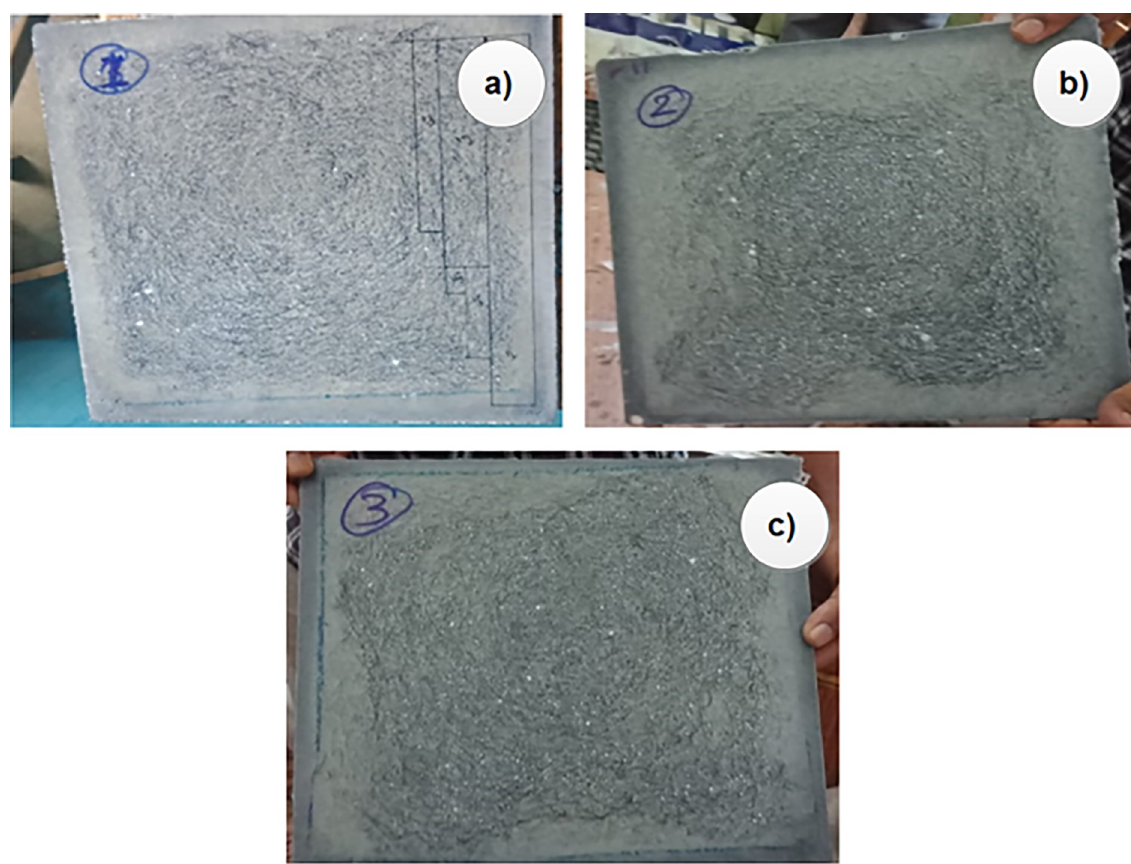
Fig 1. Composite plate with varying r-GO addition a) 0.1 wt.% b)0.2 wt.% c) 0.3wt.%.